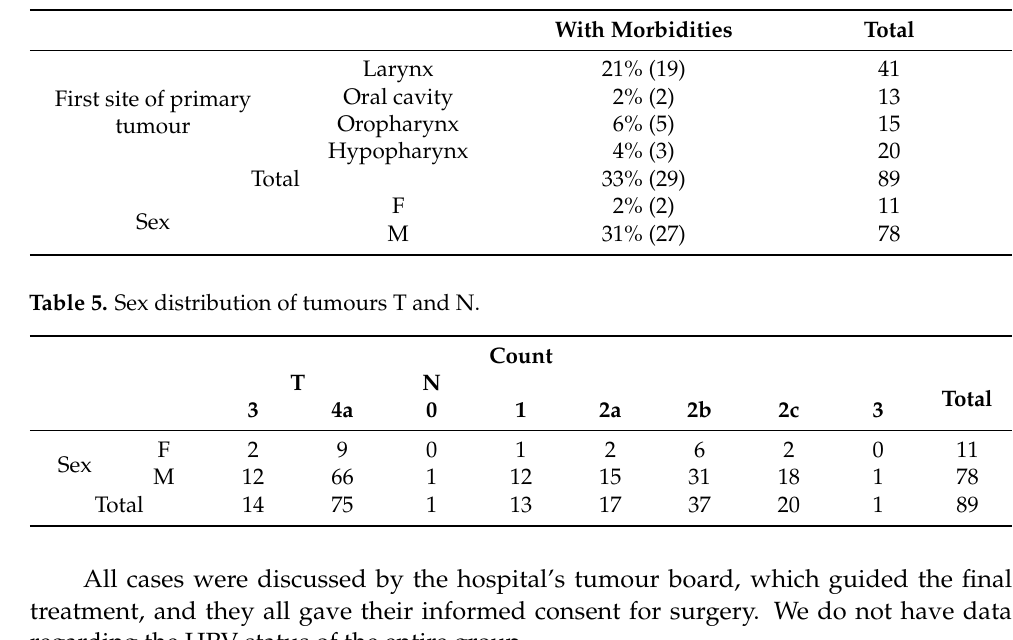
Table 4. First site, sex distribution, and morbidities.